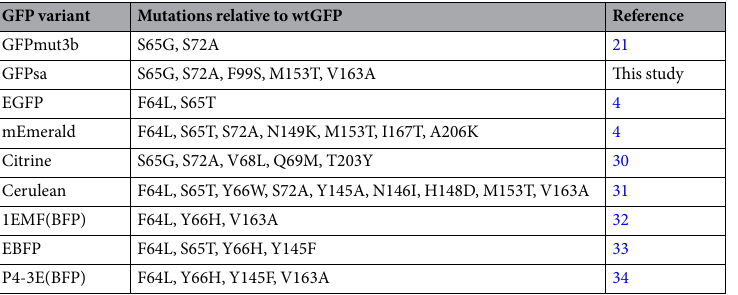
Table 3. GFP variants used in this